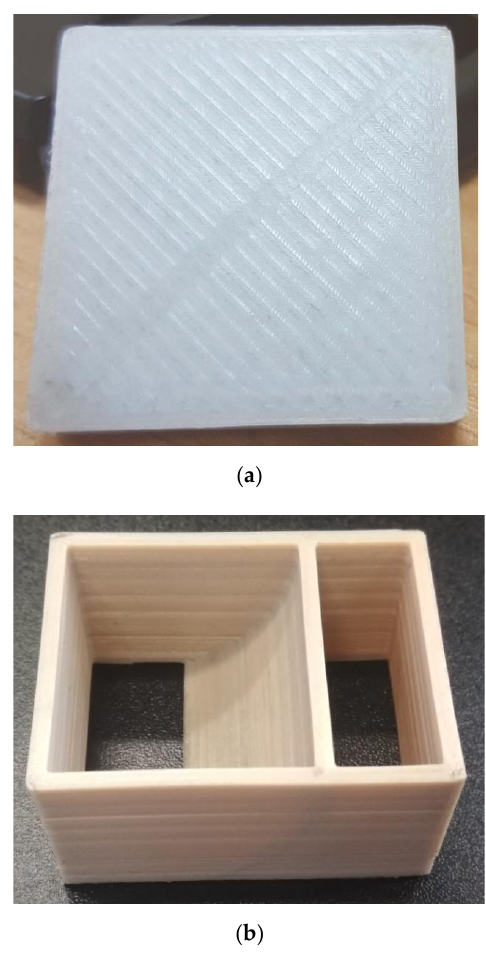
Figure 13. ( a ) Appearance of the test product surface printed of polyamide (PA); ( b ) appearance of the showpiece printed from polyetheretherketone (PEEK).